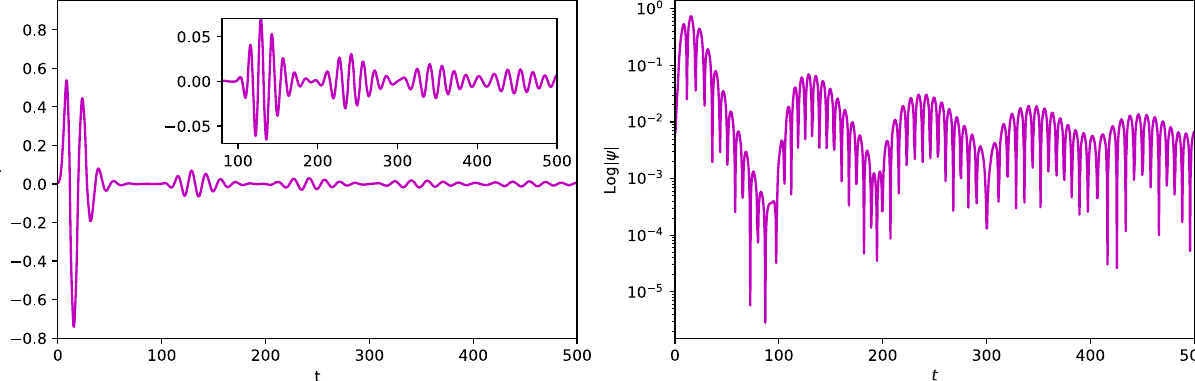
Fig. 10 The GWs echoes of electromagnetic field perturbation (left panel) and semilogarithmic plots for the GWs echoes of electromagnetic field (right panel) to black bounces in a cloud of strings with M = 0 . 5 , l = 1 , L = 0 . 1 , a = 1 . 13